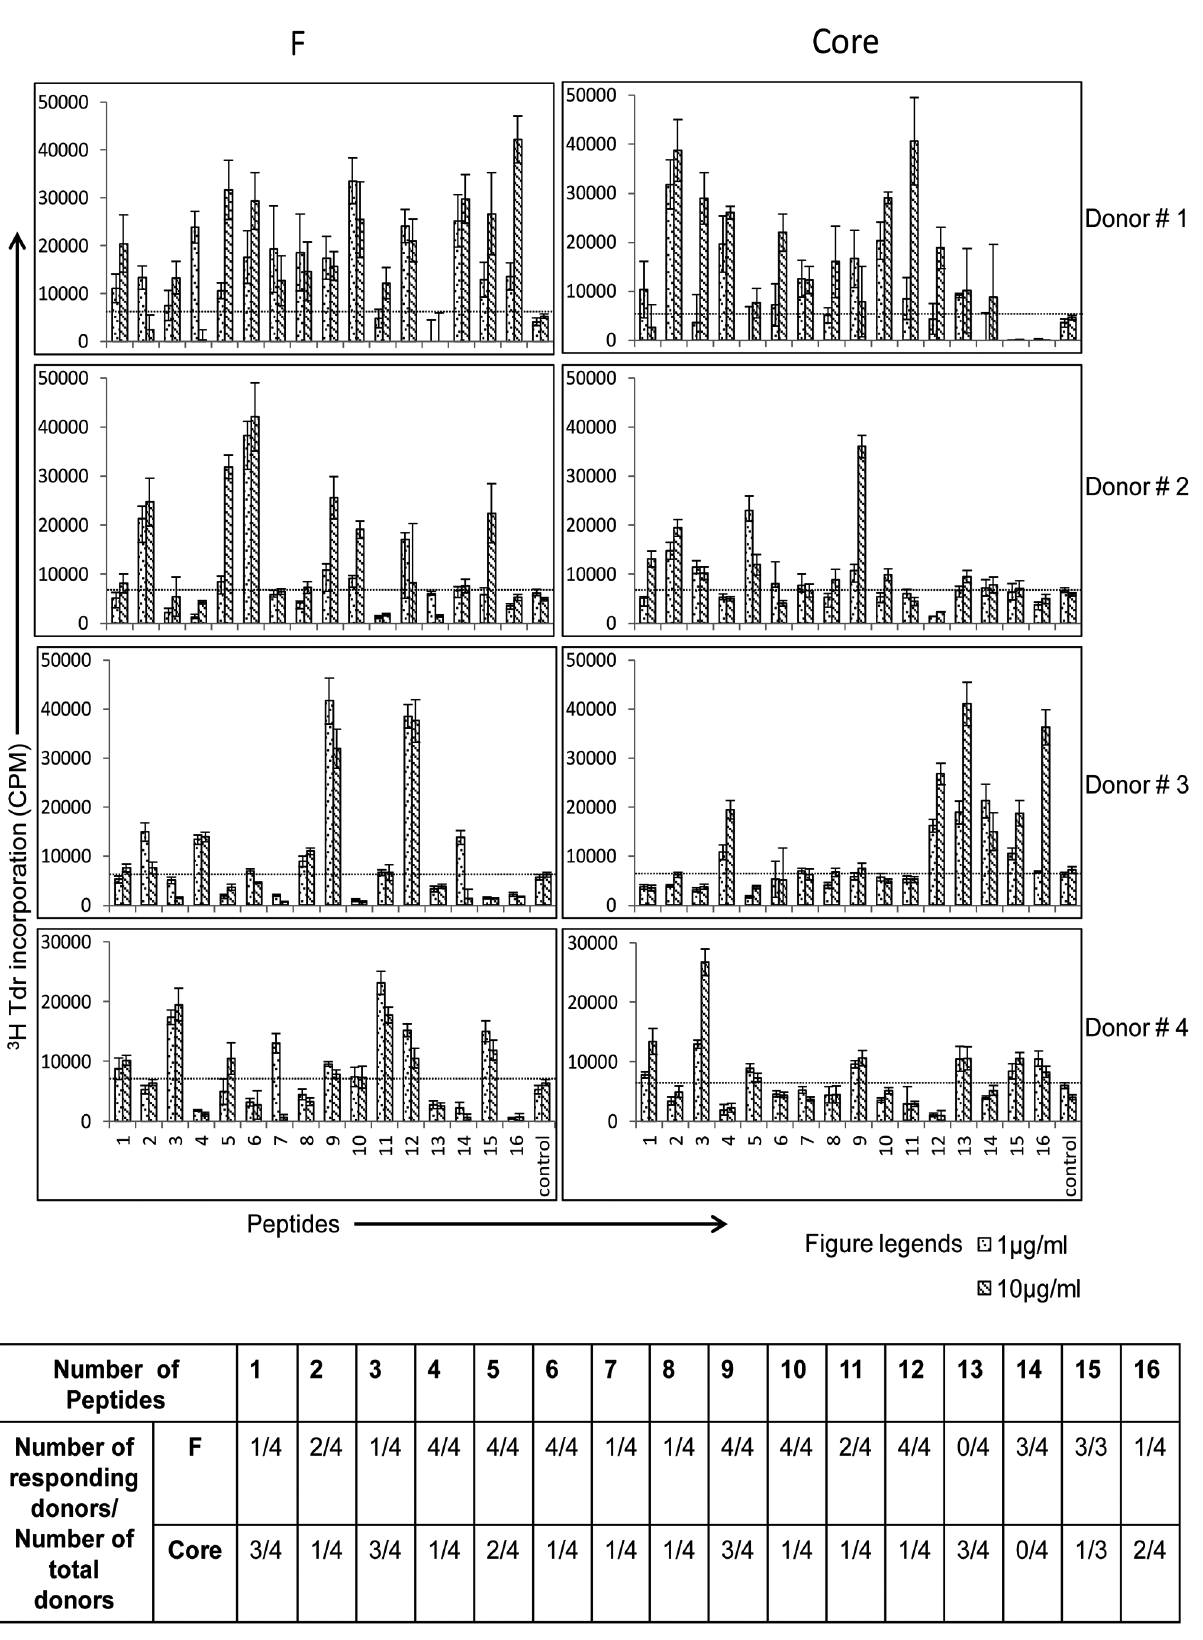
Figure 8. Invitro priming with DCs expressing F and core proteins leads to peptide dependent proliferation of CD4 + T cells in secondary cultures. The counts per minute (CPMs) shown are mean 6 standard error of individual CPMs subtracted with no-antigen groups from